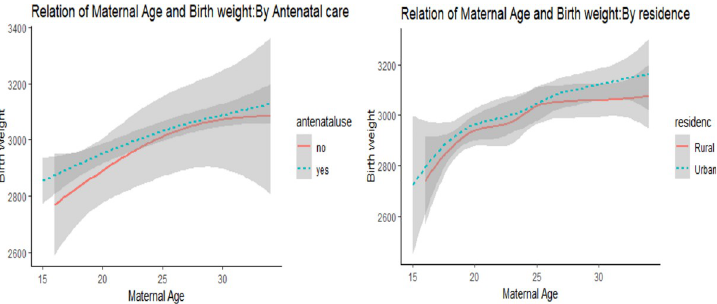
Fig 1. The relationship of women’s age and birth weight by antenatal use and residence among women who gave birth in public health facilities, East Gojjam zone, Northwest Ethiopia, 2018.